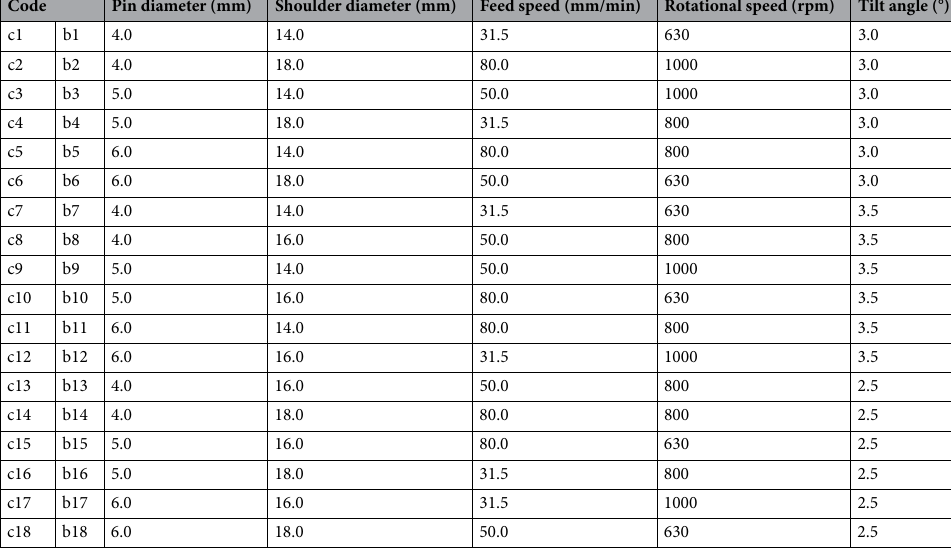
Table 1. Taguchi design of experiment parameters (Specimens labeled as c and b for conical and threaded cylindrical pins, respectively).